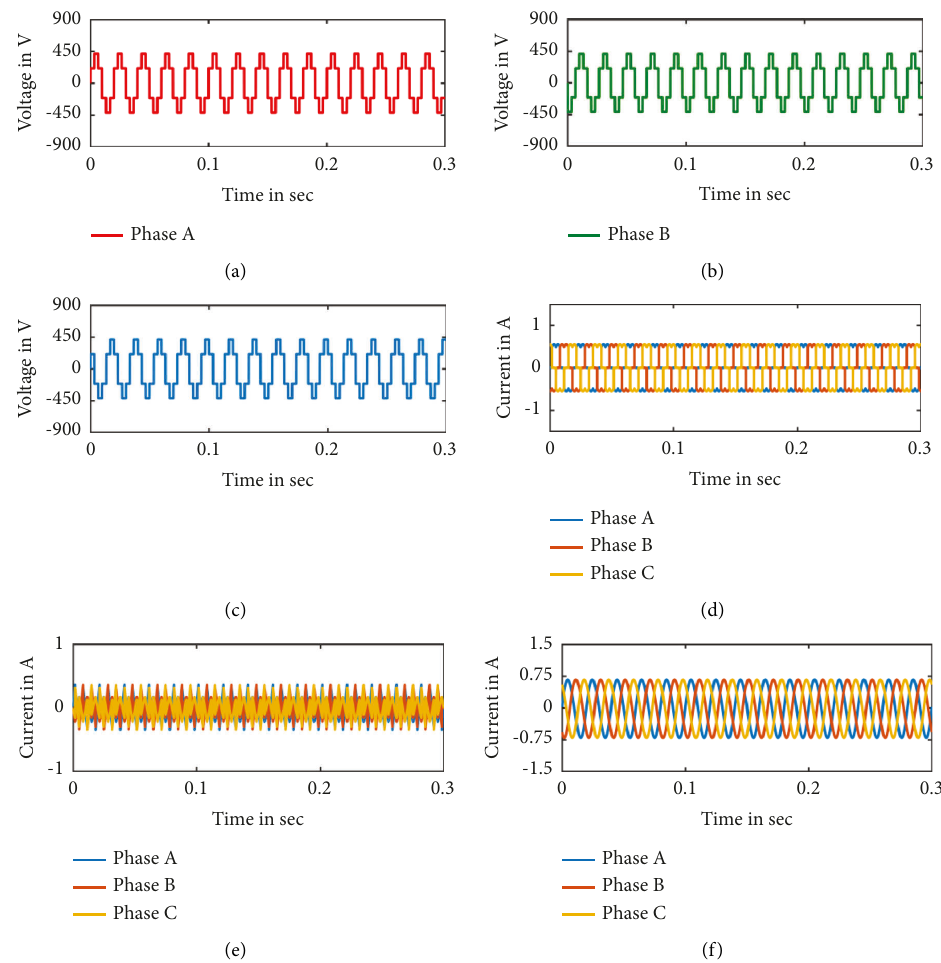
Figure 15: Simulation results proposed MMPIFC boost converter operated PV-SHAPF under constant load. (a) Phase A voltage of TPTL inverter. (b) Phase B voltage of TPTL inverter. (c) Phase C voltage of TPTL inverter. (d) Source current before compensation. (e) Injected current. (f) Source current after